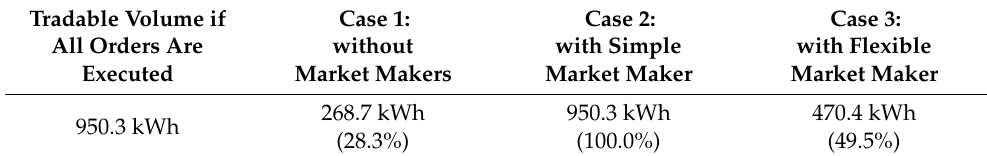
Table 11. Comparison of executed volumes for the three cases.